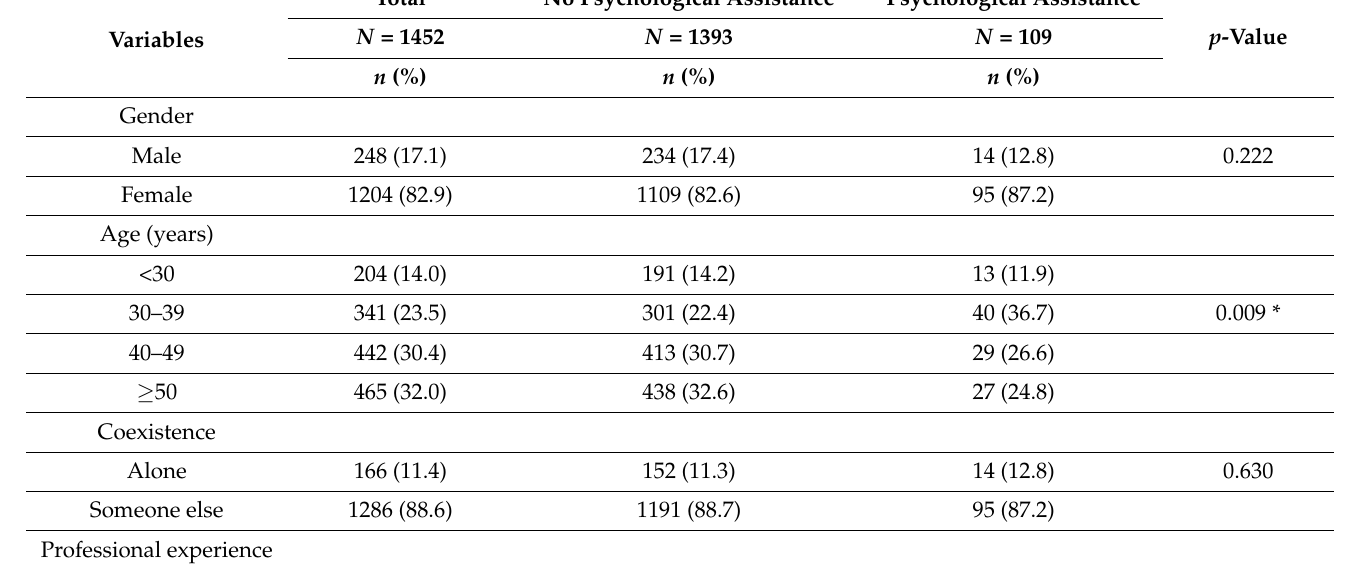
Table 3. Candidates for psychological assistance according to sociodemographic, professional and psychological variables.